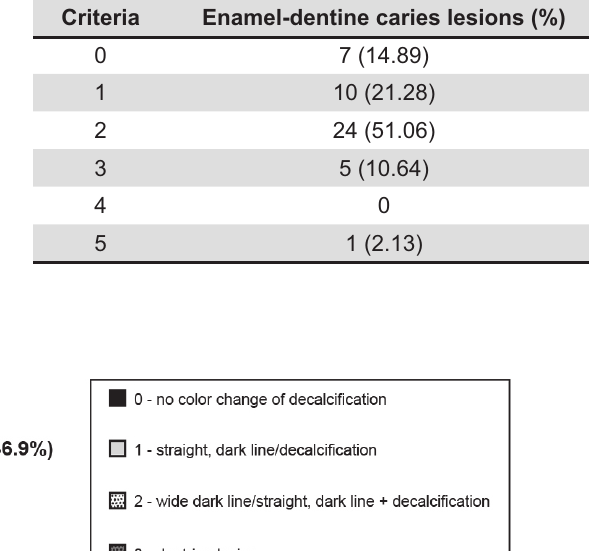
Table 1- Distribution of teeth with enamel-dentin caries based on Weerheijm, Gruythuysen and Van Amerongen 19 (1992) clinical criteria Criteria